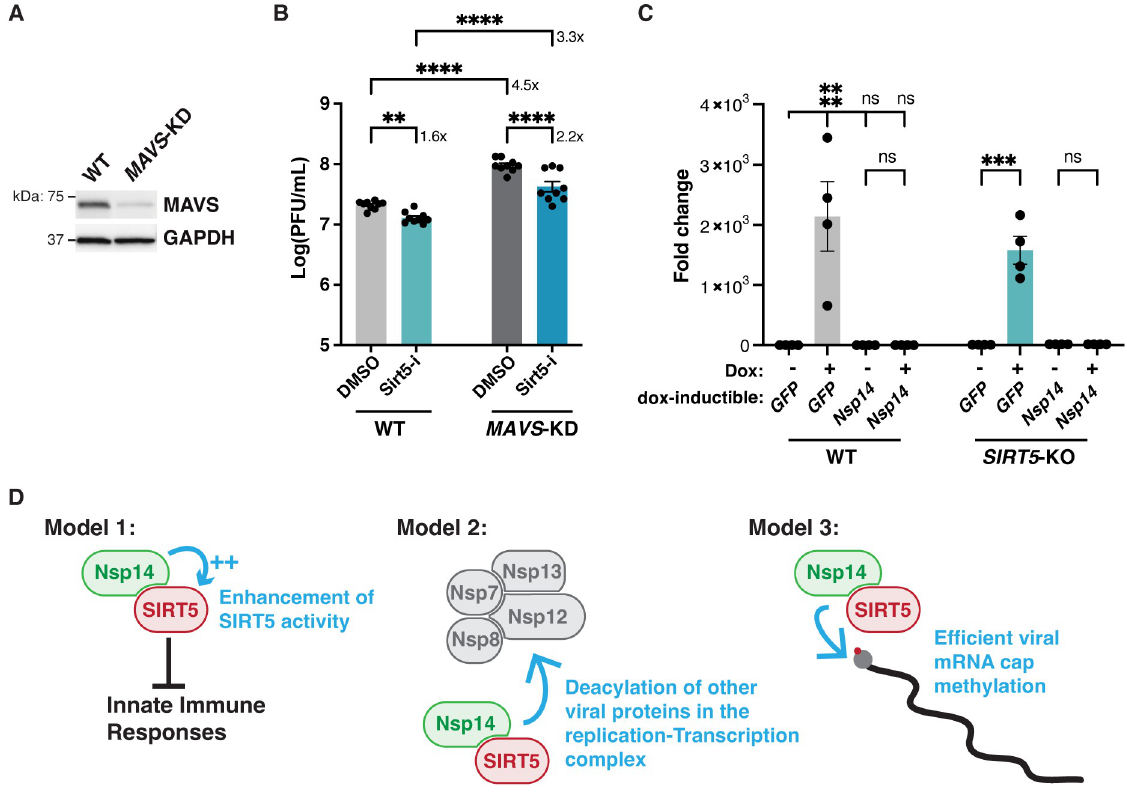
Fig 8. SIRT5 proviral activity is independent of the MAVS signaling pathway. A . Western blot showing 90% reduction of MAVS in A549-A/T cells transduced with a CRISPR lentivirus against MAVS. A549-A/T cells stably co-express ACE2 and TMPRSS2. B . Viral titers in MAVS- KD cells treated with DMSO or SIRT5 inhibitor Sirt5-i, after infection with SARS-Cov-2 for 3 days at MOI = 0.1, as shown by plaque assay. Sirt5-i had a similar effect in WT and MAVS -KO, suggesting that SIRT5 function is independent of MAVS. n = 9. C . RT-qPCR of GFP or Nsp14 after doxycycline induction. WT and SIRT5- KO A549-ACE2 cells were stably transduced with doxycycline-inducible constructs for GFP and Nsp14. After doxycycline treatment for 48 hours at 100ng/mL, GFP was strongly overexpressed, but Nsp14 failed to be expressed. Data show fold-changes compared to the first column (WT cells transduced with GFP without doxycycline), after normalization with ACTIN . n = 4. D. Hypotheses for the role of the SIRT5/Nsp14 interaction during SARS-CoV-2 infection. In model 1, Nsp14 could enhance SIRT5 activity, which would decrease innate immune responses and favor viral replication. In model 2, Nsp14 could redirect SIRT5 to novel targets, potentially in the replication-transcription complex, where SIRT5 could deacylate other viral proteins. In model 3, the Nsp14/SIRT5 complex could be primarily involved in mRNA cap methylation. Absence or inhibition of SIRT5 would lead to incomplete cap methylation and stronger immune recognition of viral mRNA. B-C . Data show mean and SEM between biological replicates. Asterisks summarize the results of one-way ANOVAs followed by Holm–Sˇida´k multiple comparisons test (on log-transformed data for plaque assays). � : p < 0.05, �� : p < 0.01, ��� : p < 0.001, ���� : p < 0.0001.